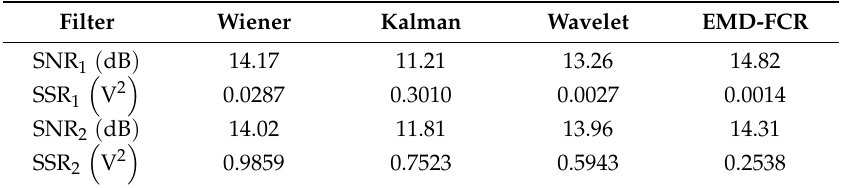
Figure 8. ( a ) Performance of different methods. ( b ) Relationship between the second harmonic intensity and gas concentration. This figure was obtained from [42]. Table 2. SNR and residual sum of squares (SSR) of different filters. This table was obtained from reference [42].